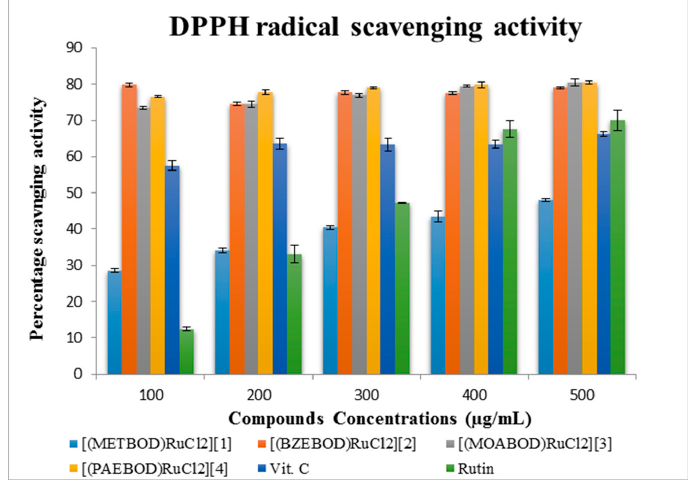
Figure 1. Heterocyclic Ru(III) complex and standard drug DPPH scavenging action.